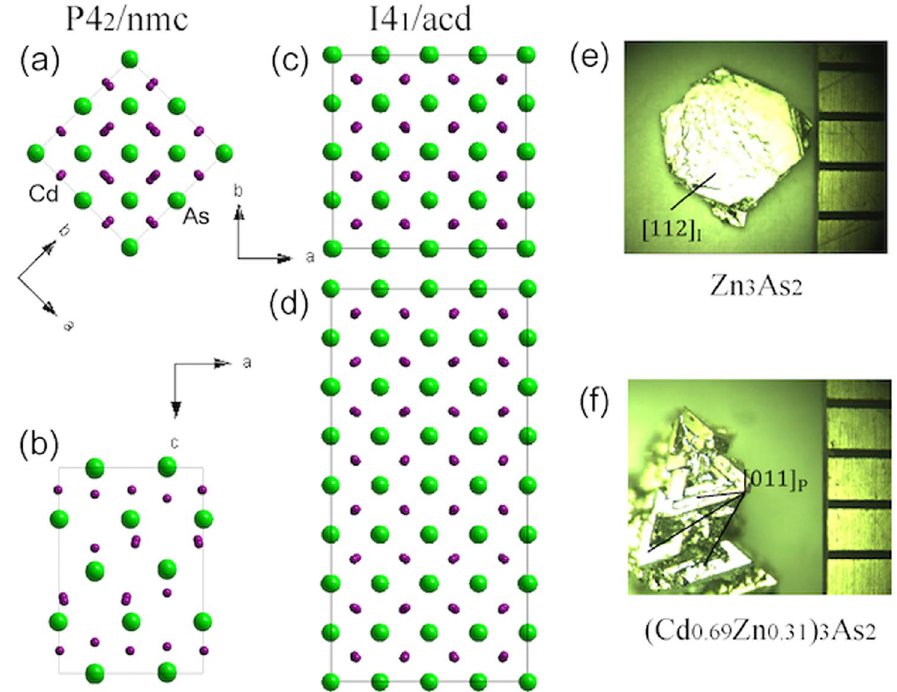
Figure 1. Panel (a–d): Unit cells of α ″− Cd 3 As 2 and α − Cd 3 As 2 viewed along c and b axes respectively. Panel (e,f): Single crystals of Zn